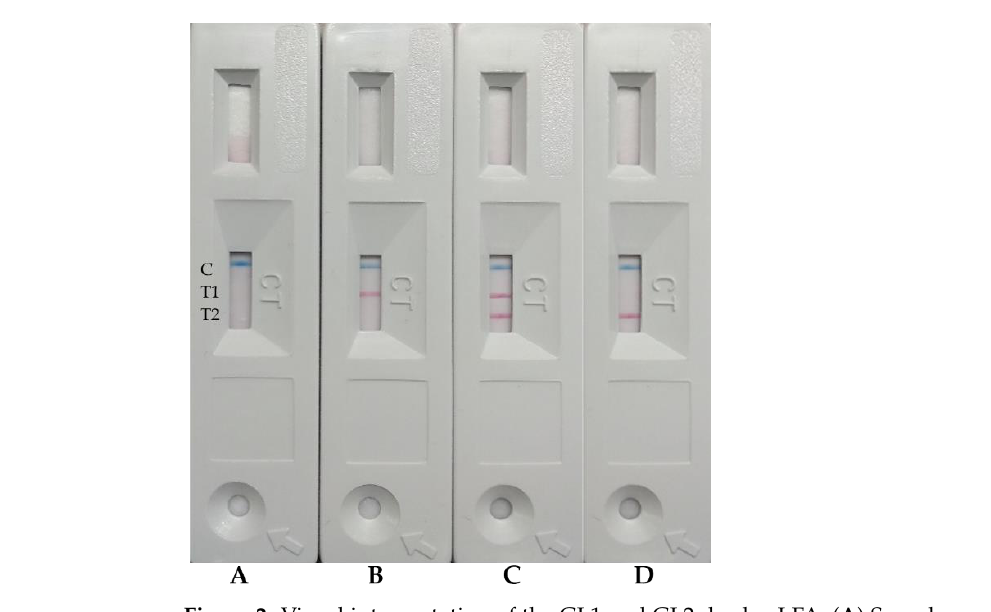
Figure 2. Visual interpretation of the GI.1 and GI.2 duplex LFA. ( A ) Sample negative for GI.1 and GI.2. ( B ) GI.1-positive sample. ( C ) GI.2-positive sample. ( D ) GI.2-positive sample containing low viral burden.